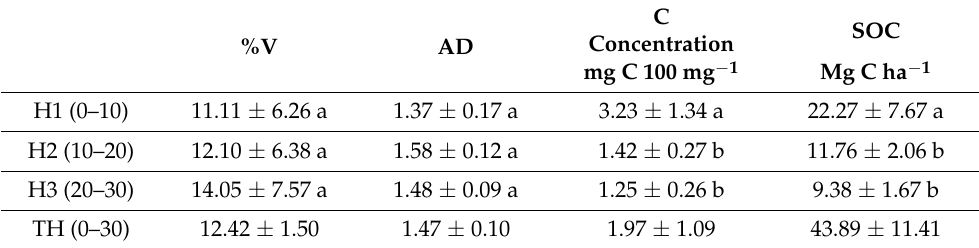
%V (stone volume percentage), D a (apparent density, g cm − 3 ), C concentration (mg C 100 mg − 1 ), and SOC (soil organic carbon, Mg C ha − 1 ) for the three analyzed horizons as average of both land uses (cultivated and abandoned) (H1: 0–10 cm; H2: 10–20 cm; H3: 20–30 cm) and for the entire profile (TH: 0–30 cm). Comparison between horizons; a, b: different letters indicate significant differences (Student’s t -test and Mann–Whitney U-test, p <